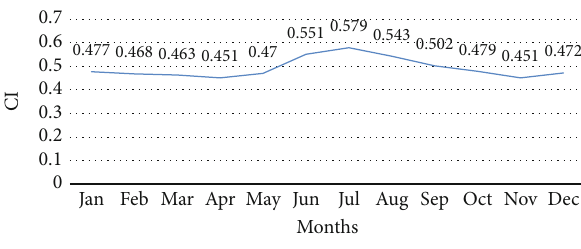
Figure 48: Monthly clearness index (CI) for Rwanda.